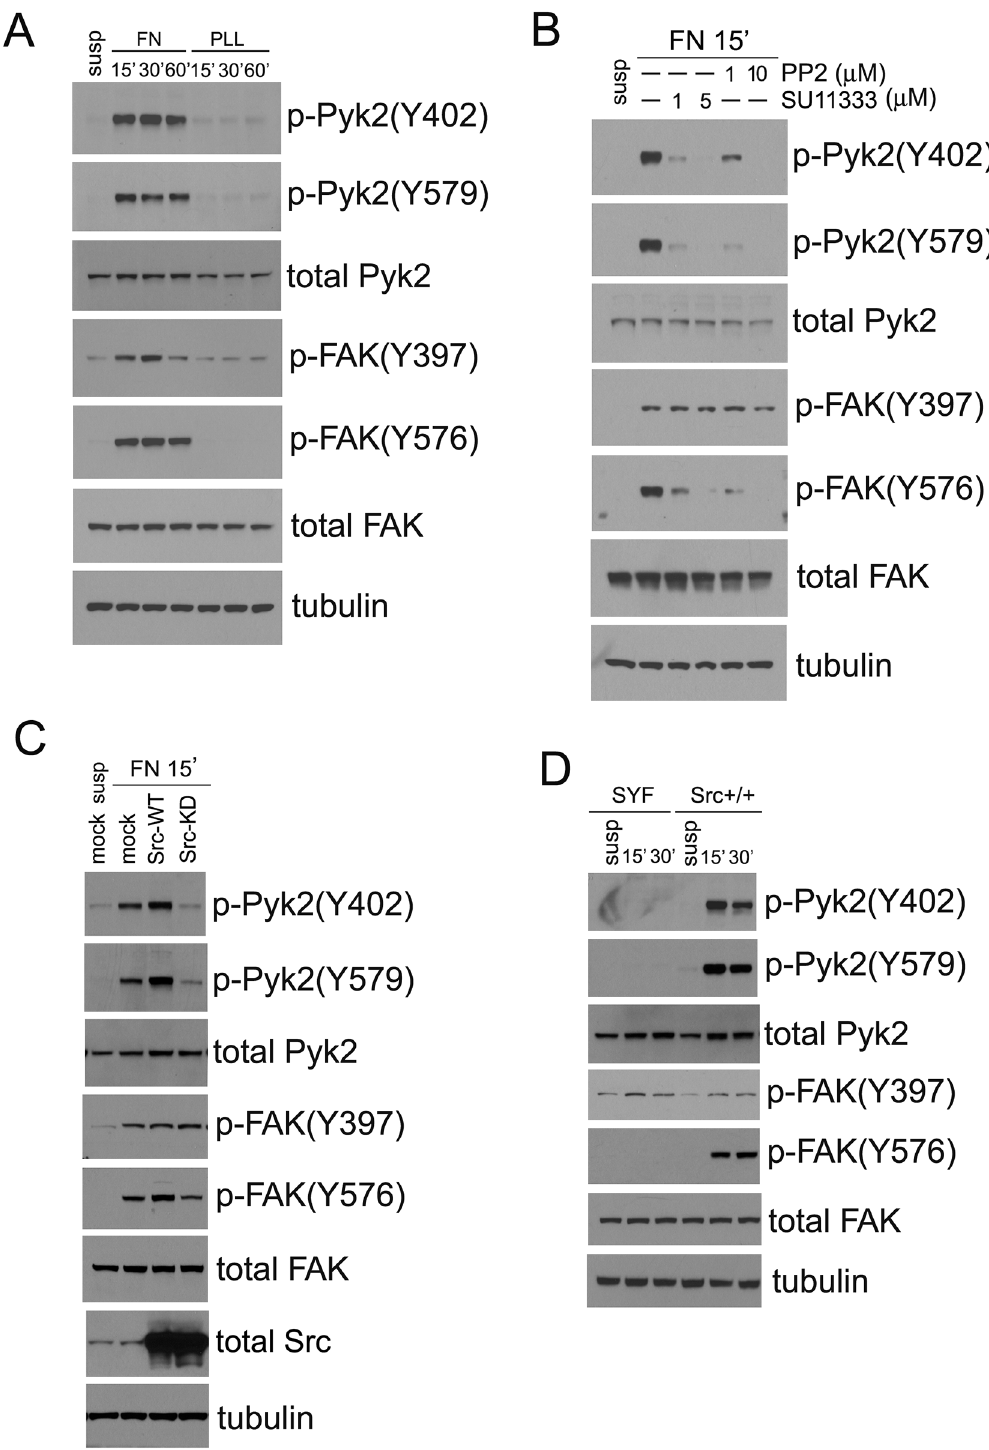
Fig 1. Src activity is required for Pyk2 phosphorylation in cells plated on fibronectin. A, serum-starved HeLa cells were detached and kept in suspension in DMEM containing 0.5% BSA for 1 hr. Cells were then seeded on fibronectin- or poly-l-lysine (PLL)-coated dishes, and allowed to attach for the indicated times. Phosphorylation of Pyk2 and FAK was examined by immunoblot, as indicated. B, HeLa cells were kept in suspension with or without indicated Src inhibitors for 1 hr before the attachment to fibronectin-coated dishes for 15 min, and phosphorylation of Pyk2 and FAK was examined as above. C, HeLa cells transfected with mock, wild-type Src (Src-WT) or kinase-dead mutant (Src-KD) were kept in suspension for 1 hr then were attached to